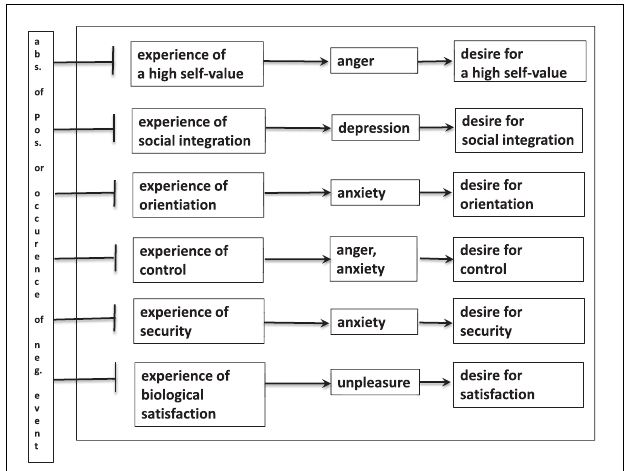
FIGURE 12 | Hypothetical structure of conscious experience, composed by the list of basic needs of Grawe. In this situation they are not satisfied by occurrence of contra-productive stimuli that evoke basic emotions that in turn induce (or accompany) upcoming desires to experience satisfaction of the respective desires.